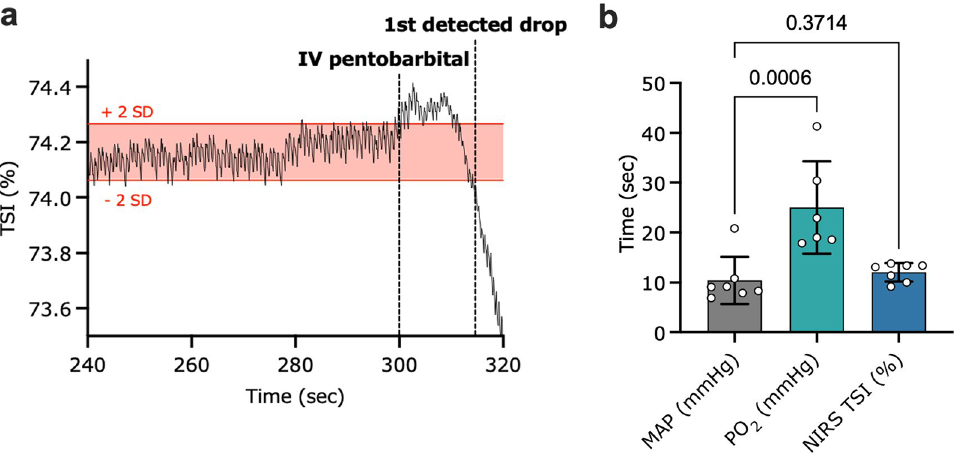
Figure 4. Euthanasia-to-first change in hemodynamics for MAP, spinal cord PO 2 and NIRS-derived TSI (%) and O 2 Hb. ( a ) Representative figure of a NIRS TSI (%) trace pre- and immediately following pentobarbital infusion. The first detected drop in the signal was defined as the first value two standard deviations below baseline (established over the last 60 s prior to pentobarbital administration). ( b ) Time (sec) to the first change in carotid MAP, spinal cord PO 2 and hindlimb TSI (%) signals in response to euthanasia ± SD. MAP vs TSI (%) (n = 7; p = 0.3714), and MAP vs spinal cord PO 2 (n = 6, p = 0.0006) were analyzed using paired student’s t-tests (level of significance p < 0.05); TSI (%) tissue saturation index, MAP mean arterial pressure, PO 2 partial pressure of